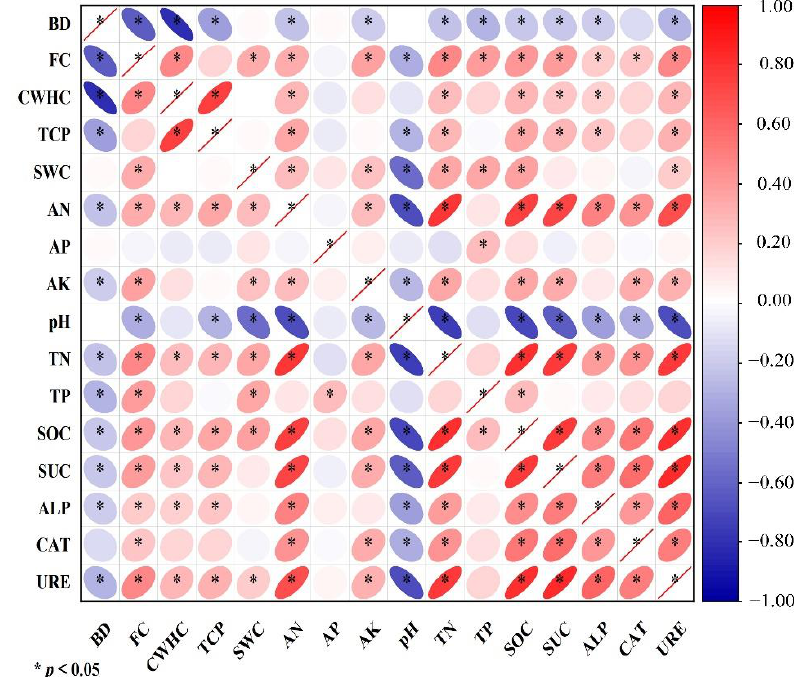
Figure 3. Correlation analysis on the soil indicators. Table 3. The indicator weight of soil quality